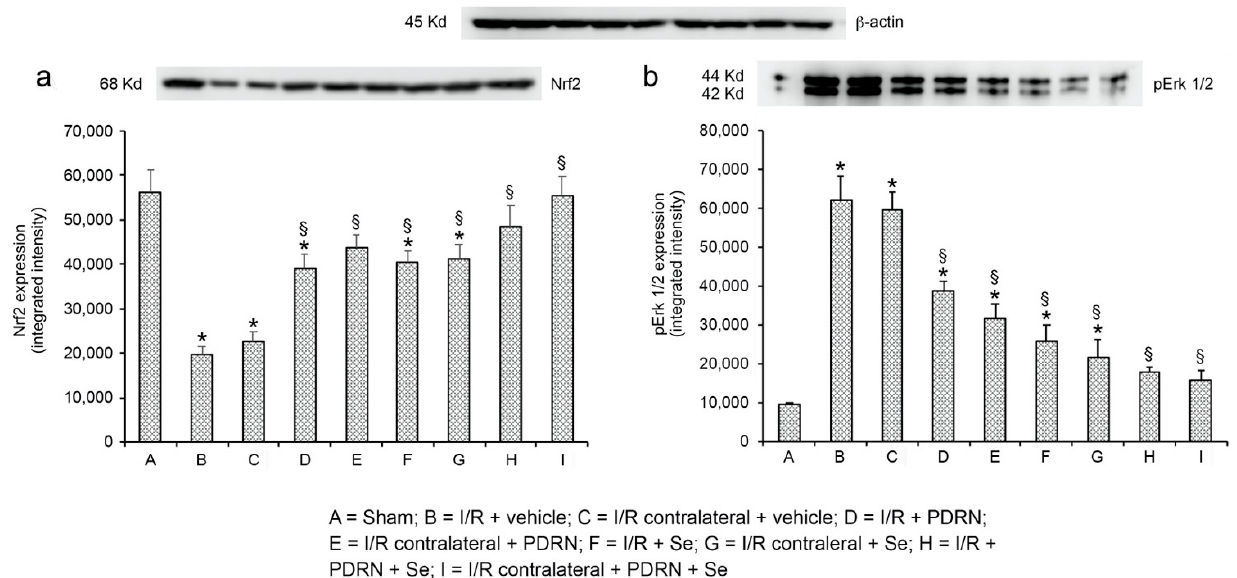
Figure 1. Representative Western blot analysis of Nrf2 ( a ) and pErk 1/2 ( b ) in testes of sham, I/R + vehicle, I/R contralateral + vehicle, I/R + PDRN, I/R contralateral + PDRN, I/R + Se, I/R contralateral + Se; I/R + Se + PDRN; I/R contralateral + Se + PDRN rats. * p ≤ 0.05 versus sham; § p ≤ 0.05 versus I/R. Bars represent the mean ± SD of seven experiments.